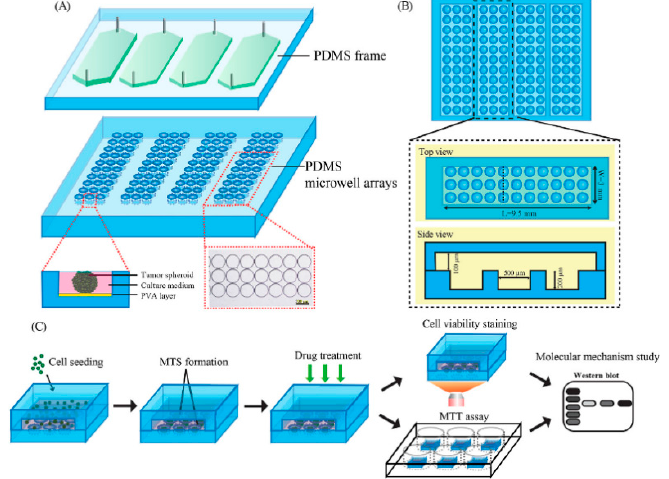
Figure 8. ( A ) Schematic illustration of the microfluidic device for MTS formation and drug screen- ing application. ( B ) Top and side views of the microfluidic device. ( C ) The process of MTS for- mation and drug screening. (Reproduced from Reference